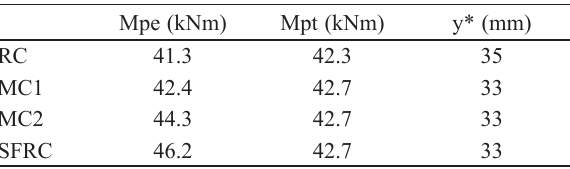
Table 4. Comparison of experimental and theoretical yielding moment of beams tested (average